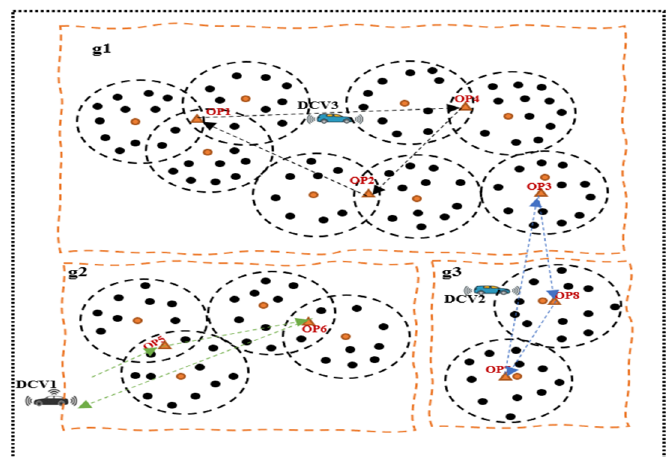
Figure 10. A working example of the proposed model using a single DCV.